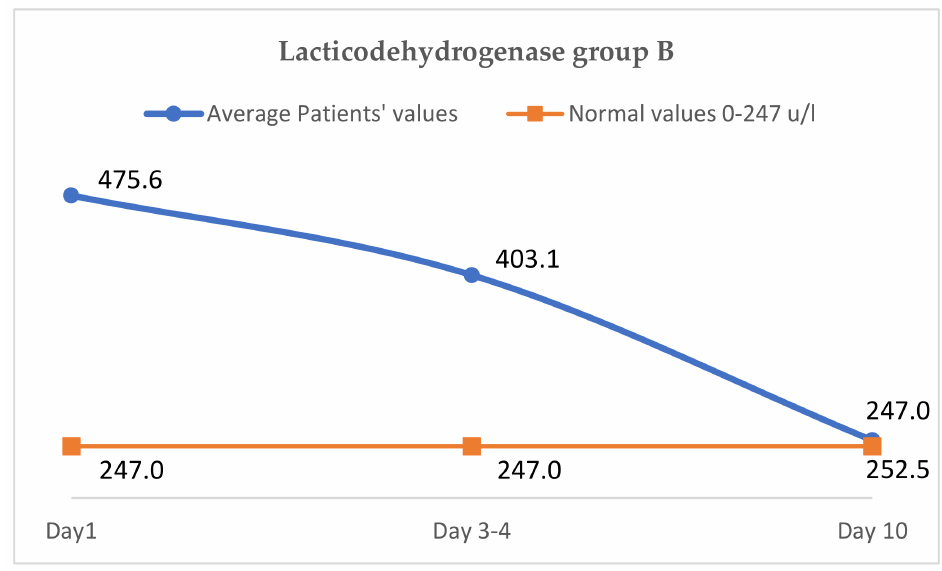
Figure 5. Variation of lactic dehydrogenase group B. 3.8. Evaluation of Ferritin (Normal Values 10–291 ng/mL, in Cytokine Storm, Increases to over 700